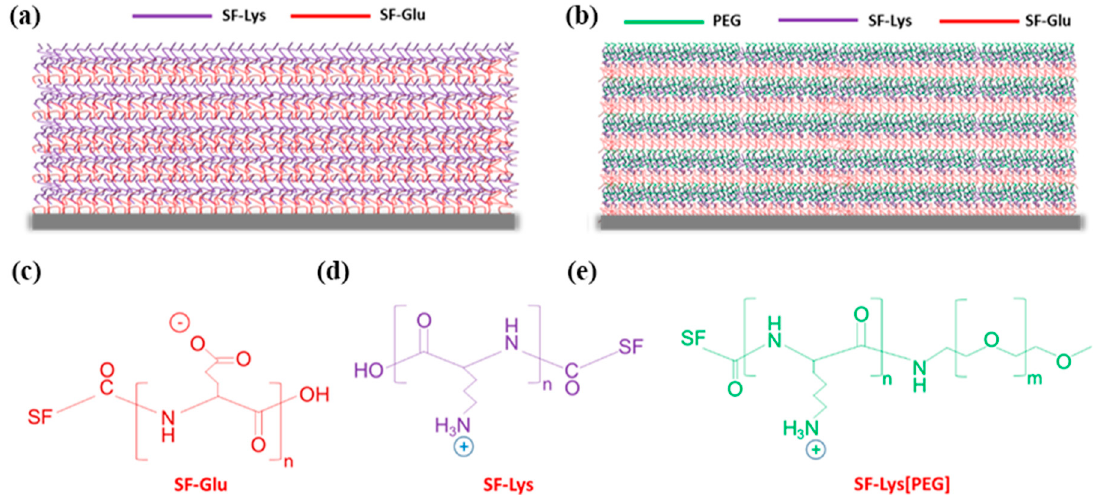
Figure 4. LbL silk ionomer films fabricated in this study: ( a ) ((SF)-poly- L -glutamic acid (Glu)/SF- poly- L -lysine (Lys)) 5 and ( b ) (SF-Glu/SF-Lys[poly(ethylene glycol)(PEG)]) 5 ; chemical structure of silk ionomers: ( c ) silk fibroin (SF)-poly- L -glutamic acid (Glu), ( d ) SF-poly- L -lysine (Lys), and ( e ) SF- Lys[poly(ethylene glycol) reproduced with permission from [64].